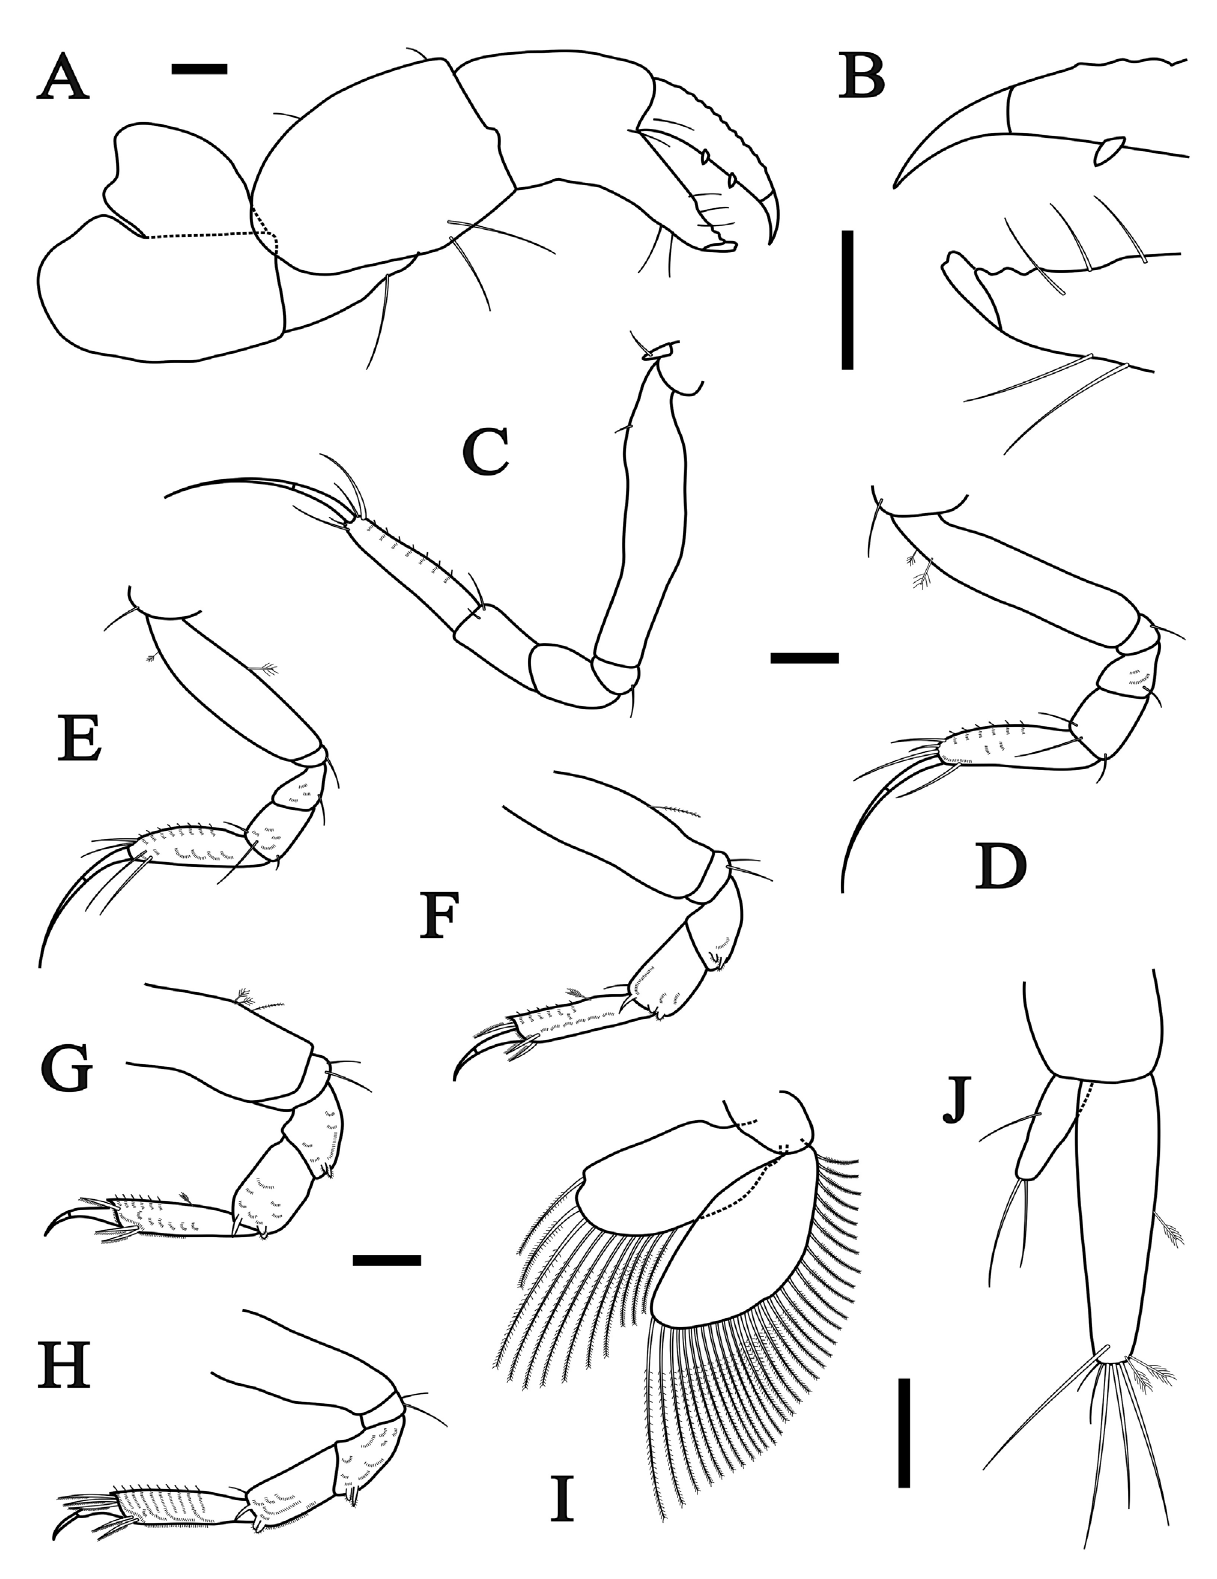
Figure 2. Tanaopsis bamberi sp. nov., female paratype, length 4.5 mm, MNRJ 23402. A, cheliped, with B, detail of cheliped fixed finger; C, pereopod 1; D, pereopod 2; E, pereopod 3; F, pereopod 4; G, pereopod 5; H, pereopod 6; I, pleopod; J, uropod. Scale bars = 0.1